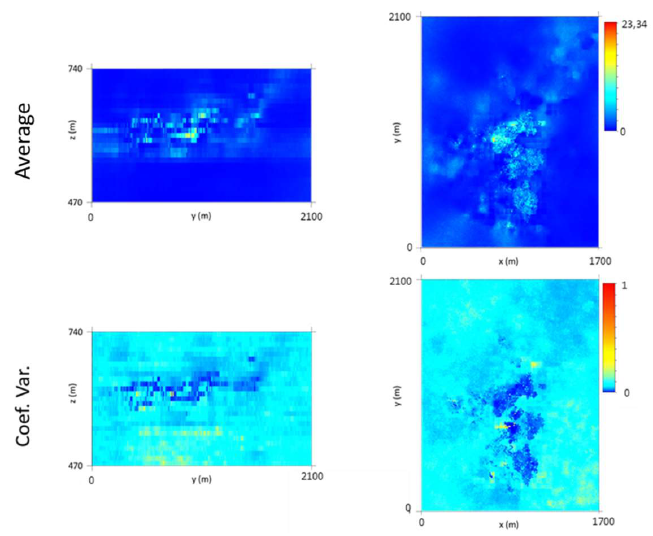
Figure 16. Results for the model of final mineral potential (in kg) (average and coefficient of variation): Px81 (left) and Pz75 (right).